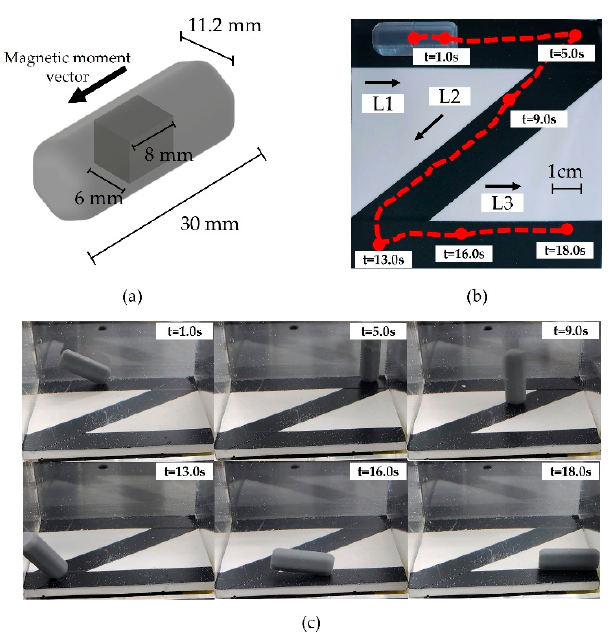
Figure 11. ( a ) Prototyped magnetic capsule used in experiment. ( b ) Z-path of the experiment and measured trajectory of capsule marked in red solid line. ( c ) Experiment of trajectory tracking.